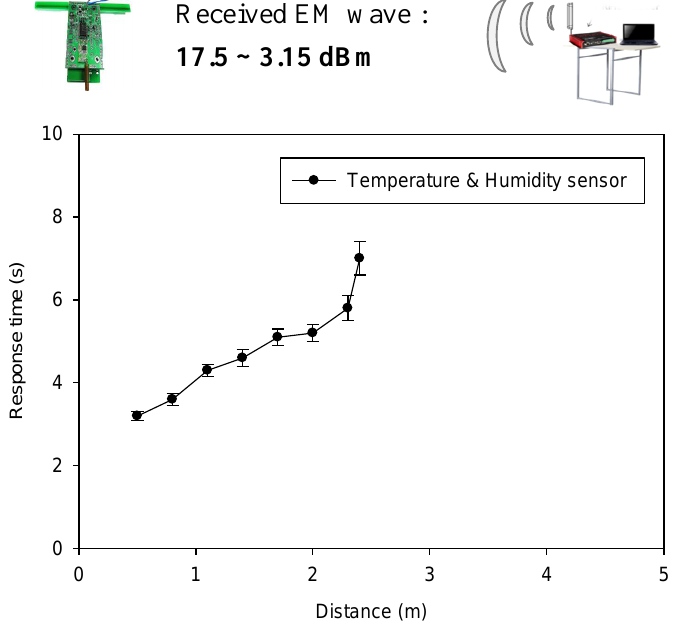
Figure 17. The response time of a WPWS equipped with temperature and humidity sensors.